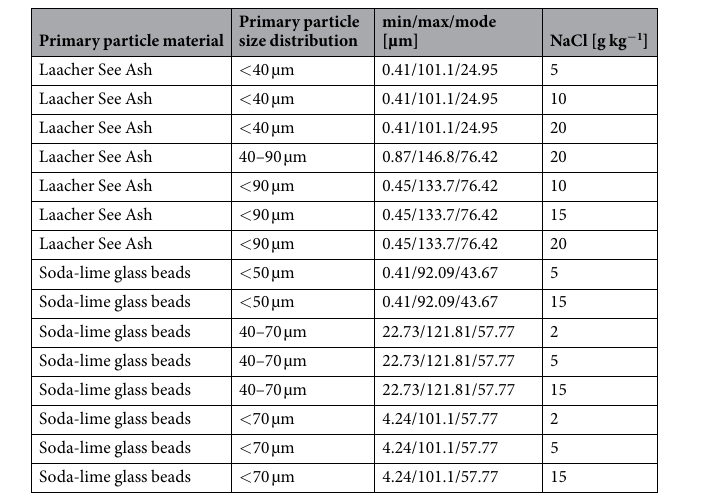
Table 1. Overview of physical characteristics of artificially produced aggregates used for impact